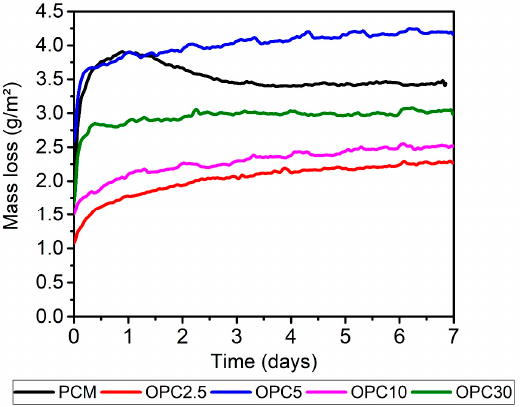
Figure 10. Mass loss during curling testing of mortars screeds: Binary mortars and Portland cement.